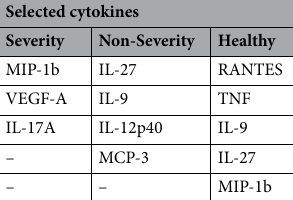
Table 7. The most significant features selected by SHAP Value and